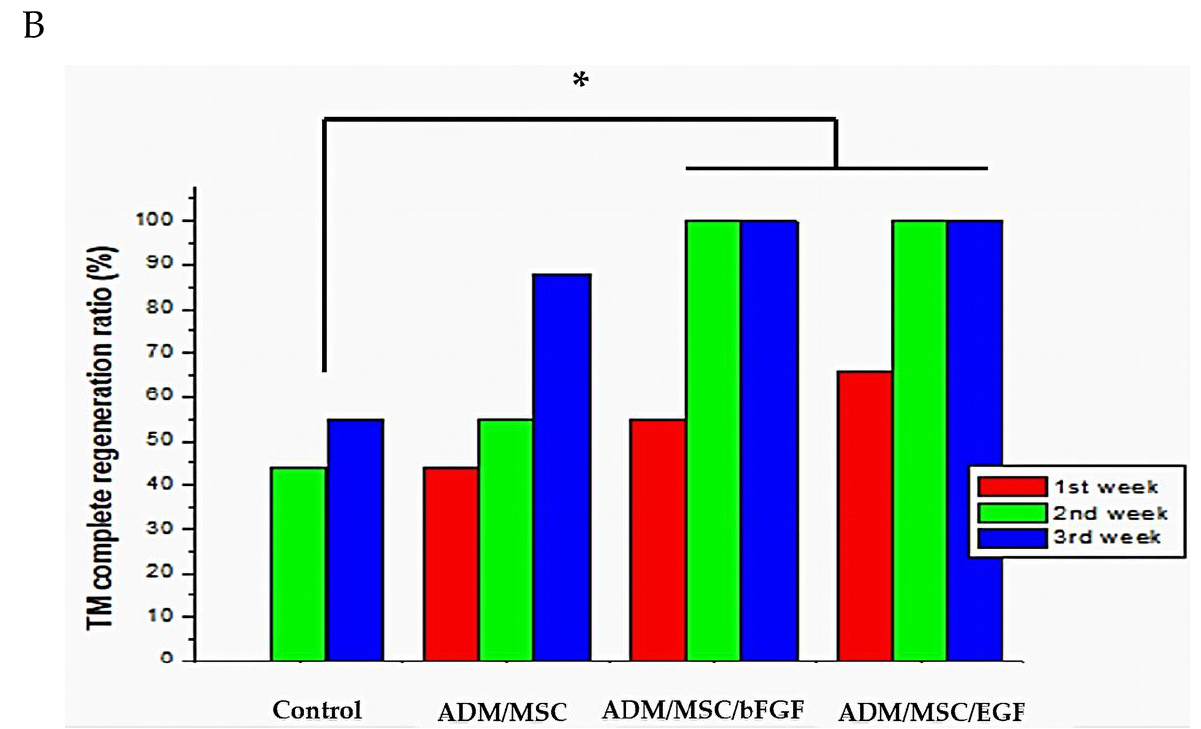
Figure 4. (A) Regeneration of Tympanic membrane. Otoendoscopy (2nd week) showed that control or ADM/MSC group causes no interval change, but overlayed scaffold in the ADM/MSC/bFGF group or ADM/MSC/EGF group findings show progression to more advanced state. Otoendoscopy (3rd week) revealed a persistent, small perforation in the control group, but intact neodrum was achieved in other groups. Among three groups, ADM/MSC/EGF group showed prominent epithelization of neodrum. ( B) The graphic photo showed the tympanic membrane regeneration ratio of different groups. Both ADM/MSC/bFGF group and ADM/MSC/EGF group showed significantly increased regeneration rate when compared with control group. (* p < 0.05).